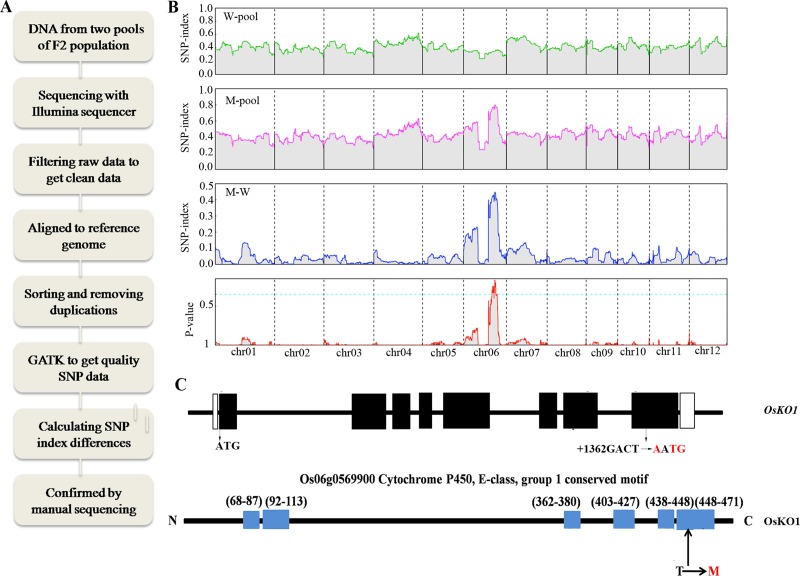
Characterization of the mutations through whole-genome resequencing and mutmap methods.(A) flowchart of the sequencing-based method. (B) Whole-genome resequencing of mutant and Nipponbare wild-type segregant F2 population to get casual mutations. Scrolling window plots show SNP index of sequencing results from wild-type pool, mutant pool and SNP index differences with their p values by chi-squared test and fisher test on 12 chromosomes. (C) Structure and mutation sites of OsKO1 gene and its corresponding protein. Black boxes indicate exons, white boxes are UTRs, red fonts are mutated nucleotids and corresponding amino acids.